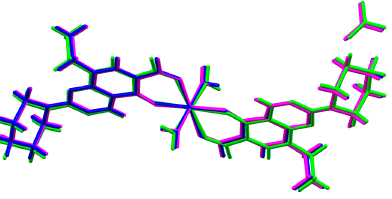
Figure 4. Overlap of the three isostructural complexes ( I = blue; II = pink; III = green).